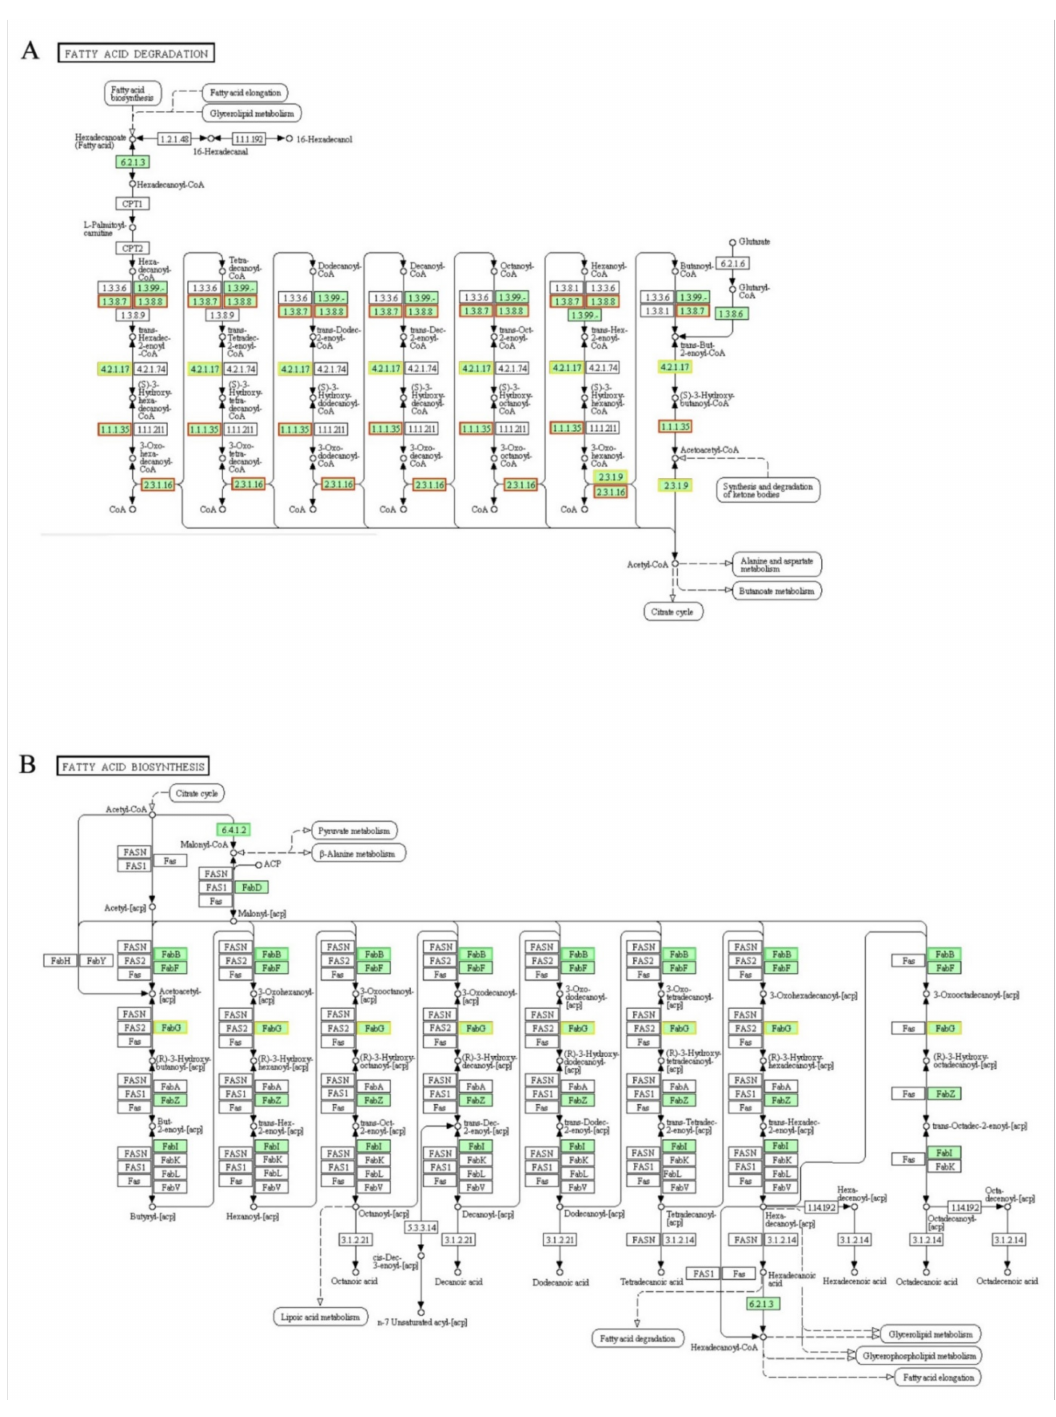
Figure 9. Significantly enriched KEGG pathway “Fatty acid degradation” ( A ) and “Fatty acid biosynthesis” ( B ); (from KEGG database, green rectangles represent proved Organism-specific gene product and green frames represent down-regulation and red frames represent